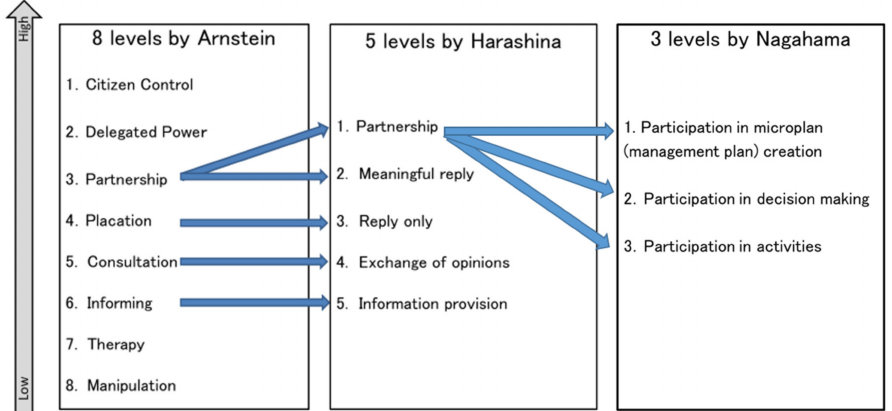
Figure 7. Subdivisions of the level of participation. Source: based on the results of the structural interview survey and